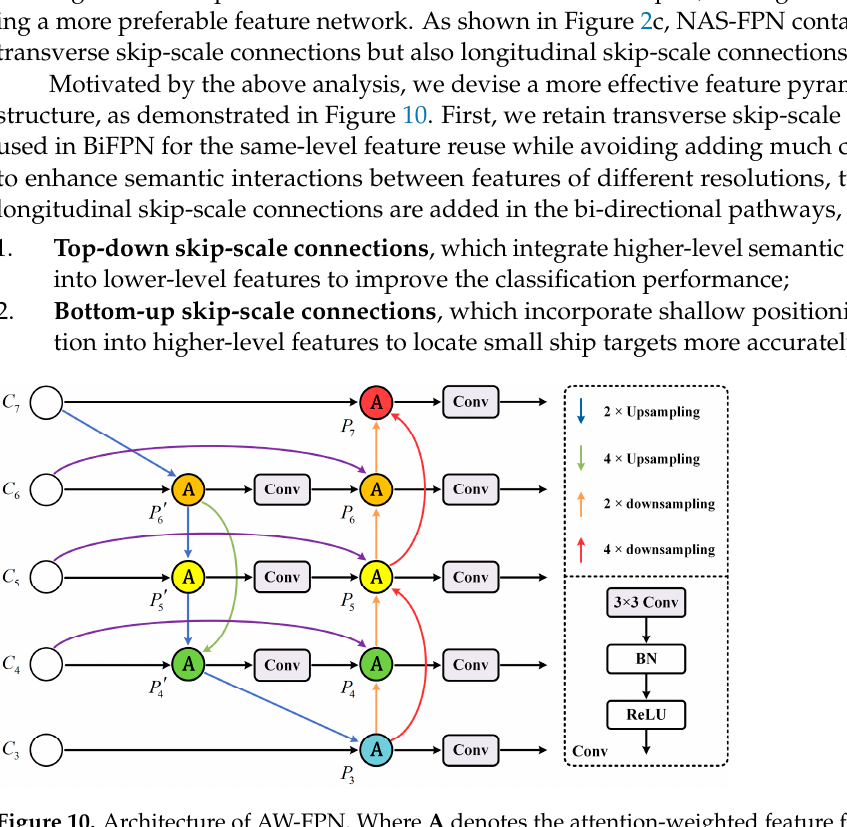
Figure 10. Architecture of AW-FPN. Where A denotes the attention-weighted feature fusion (AWF).